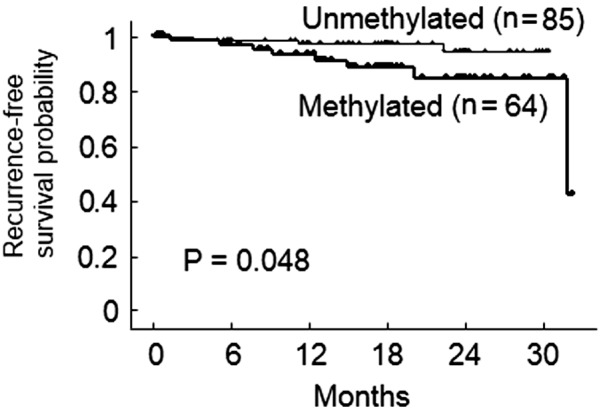
Kaplan-Meier curves for recurrence-free survival of patients with adenocarcinoma. The 2-year recurrence-free survival rates were 94.6% for patients with unmethylated IRF8 and 84.3% for patients with methylated IRF8. IRF8, interferon regulatory factor 8.